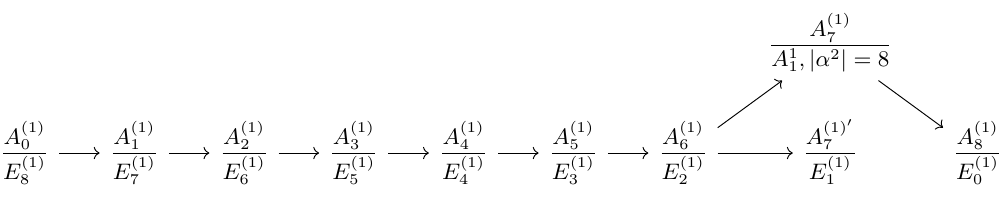
Figure 3 . q -Painlev(cid:19)e equations by surface/symmetry